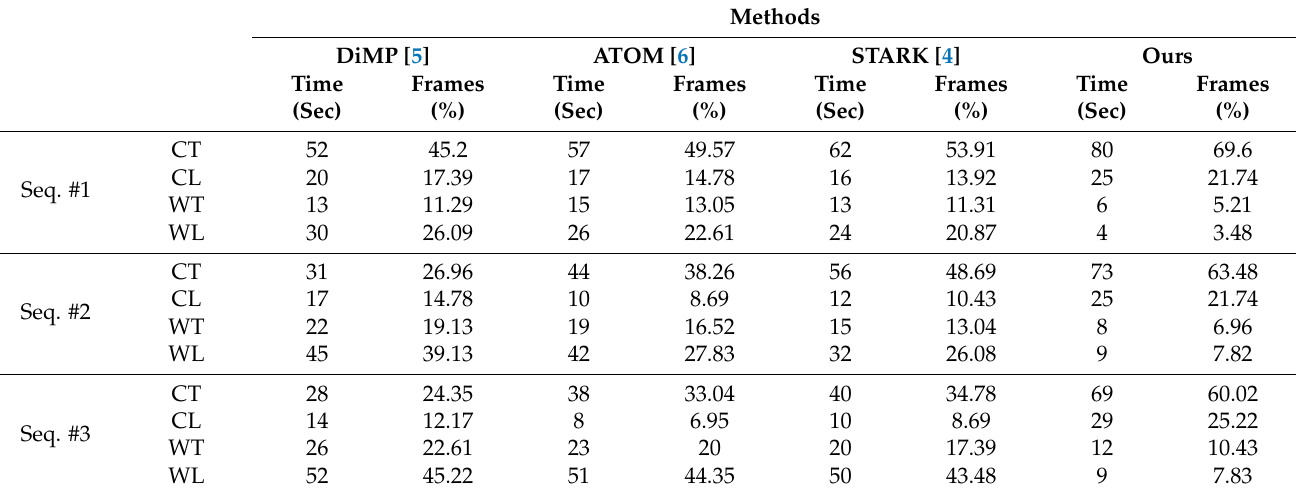
Table 9. Person Reidentification Results for Tracking in the Outdoor World.